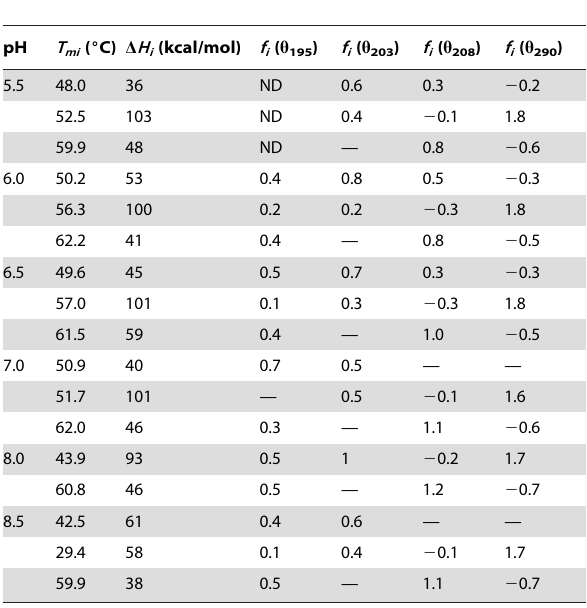
Table 2. Denaturation parameters of Cpl-7 endolysin derived from CD thermal profiles at different pH values.